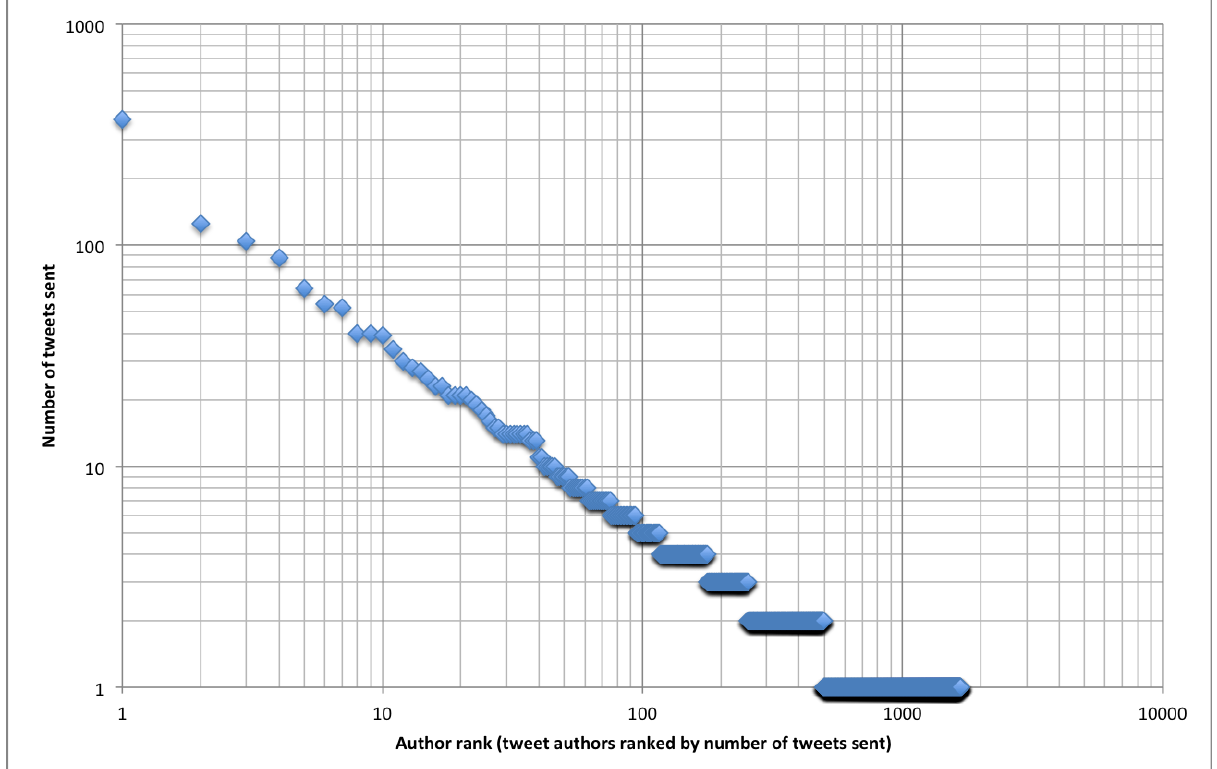
Figure 6. Tweetation density by account. Each Twitter account is ranked by the number of tweetations sent and plotted by rank on the x-axis. The y-axis shows how many tweetations were sent by each ranked account. For example, the top Twitter account ranked number 1 (@JMedInternetRes) sent 370 tweetations. Note the linear pattern on a log-log scale, implying a power